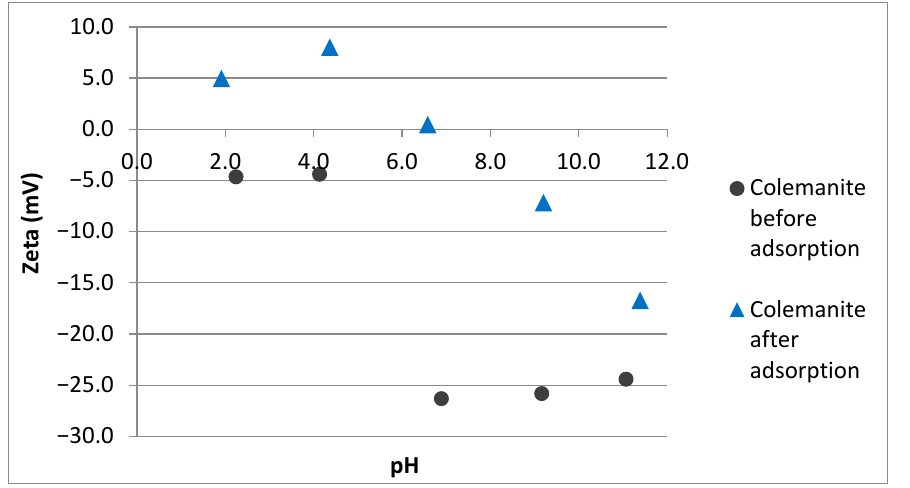
Figure 6. pH versus zeta potential of colemanite before and after adsorption.